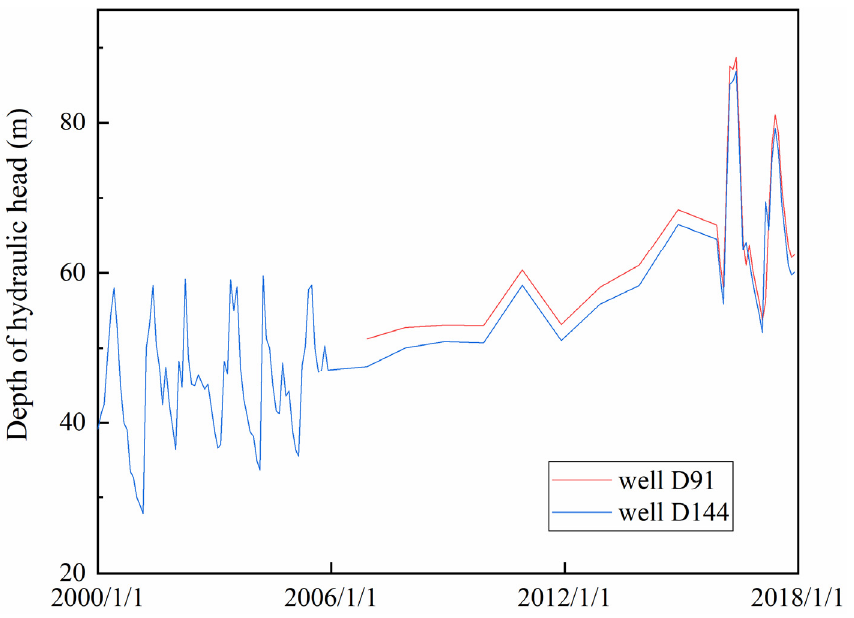
Figure 10. Time series of the depth of hydraulic head at wells D91 and D144 during 2000~2017. As mentioned in Section 4.1, the area along the Fuyang River, Fuyangxin River and Fudongpai River was relatively stable during 2009~2010 and 2015~2021. Similar to the spatial deformation pattern surrounding the Longyao ground fissure, a sharp change of deformation rate within a short distance can also be found on the boundaries of the stable area and subsidence bowl (white lines in Figure 11a). The profile of mean deformation rate during 2015~2021 indicates that the deformation rate increased or decreased by 15 mm/year, 22 mm/year and 32 mm/year at lines f1, f2 and f3, respectively (Figure 11b). The annual deformation rates show similar spatial patterns. These large gradients of deformation rate suggest that there might be three unknown fissures at the three lines.